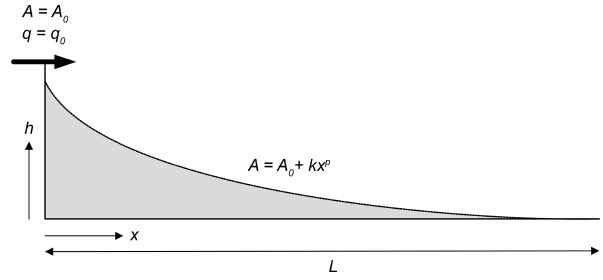
Figure 1. Experimental